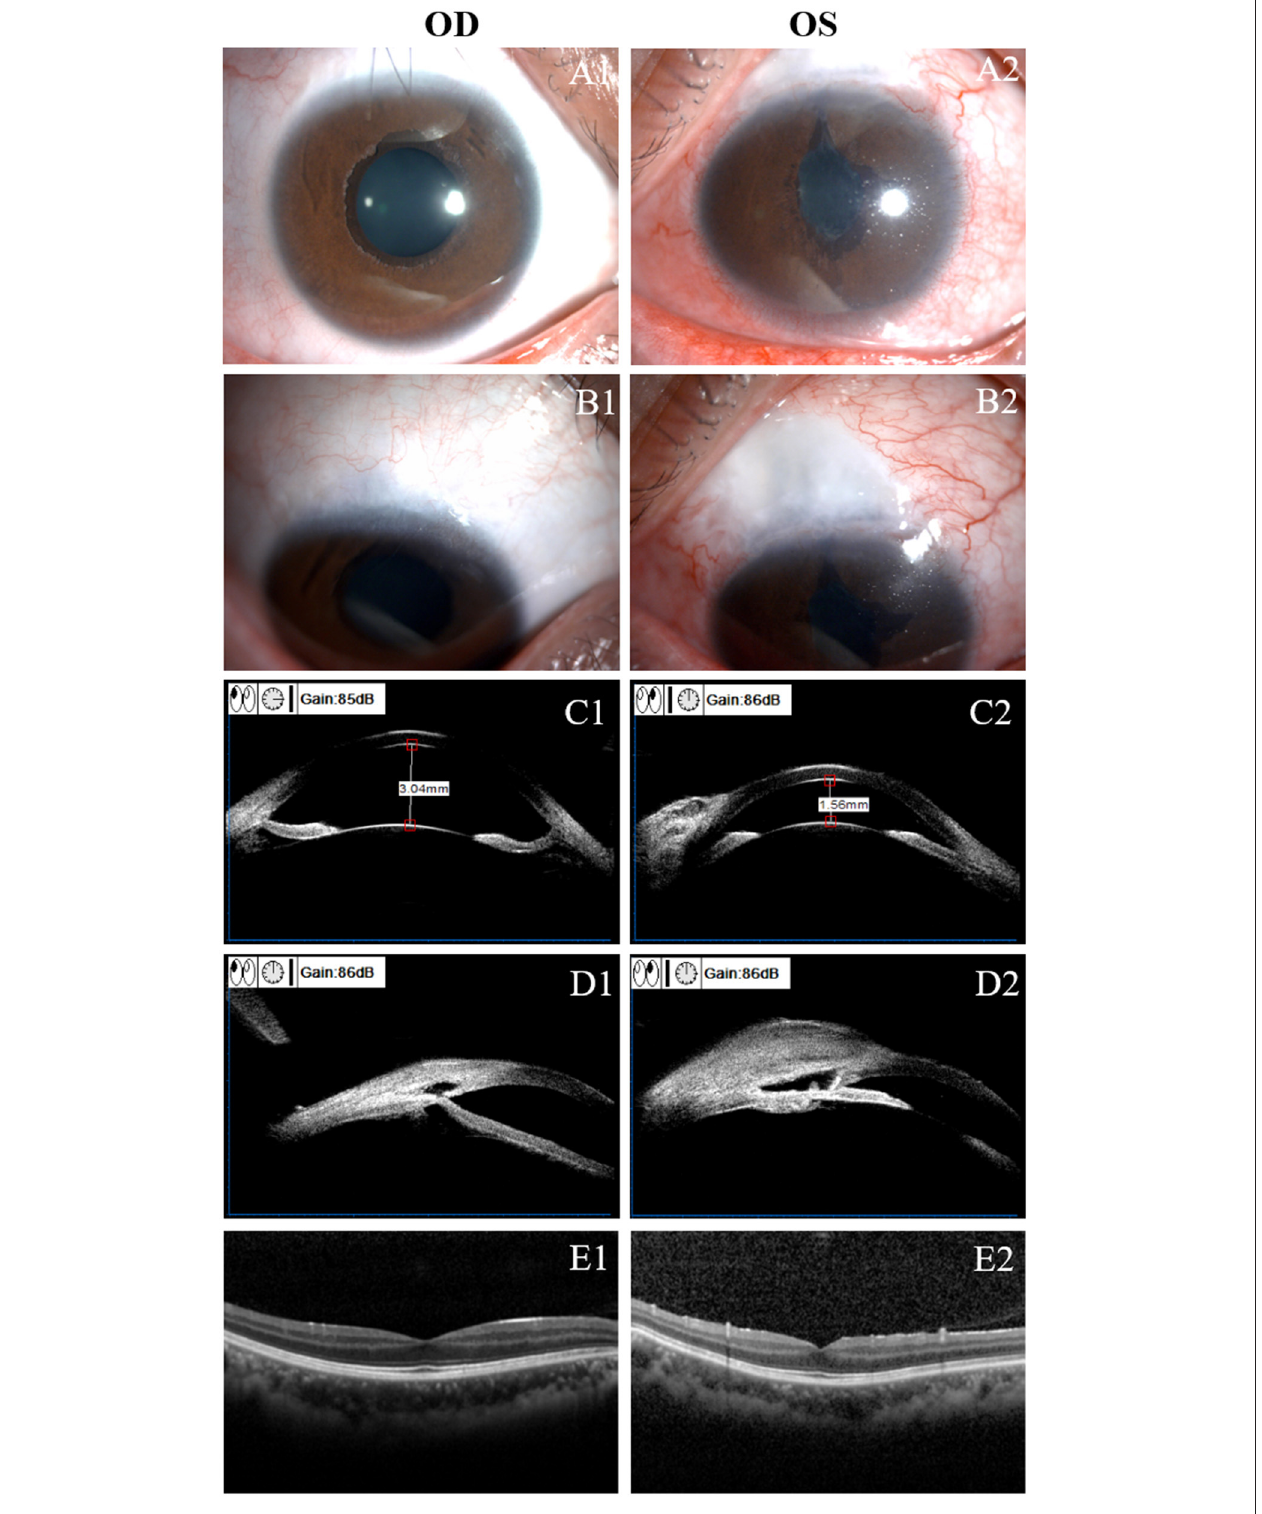
FIGURE 4 | Clinical presentation at 2-year after surgery. (A) : Slit-lamp examination of the right (OD, A1 ) and left (OS, A2 ) eye. Shallow anterior chamber and complicated cataract were found in OS. (B) : No bleb was found in the right eye (B1) and a low-lying diffuse bleb was found in the left eye (B2) . (C) : Ultrasound biomicroscopy (UBM) examination showed a normal anterior chamber depth in the right eye (C1) and a shallow anterior chamber in the left eye (C2) . (D) : UBM examination showed no obvious bleb in the right eye (D1) ; a diffuse subconjunctival bleb and a deep scleral lake was found in the left eye (D2) . Optical coherence tomography (OCT) examination in OD (E1) and OS (E2) . There was no obvious hypotony maculopathy in OS.